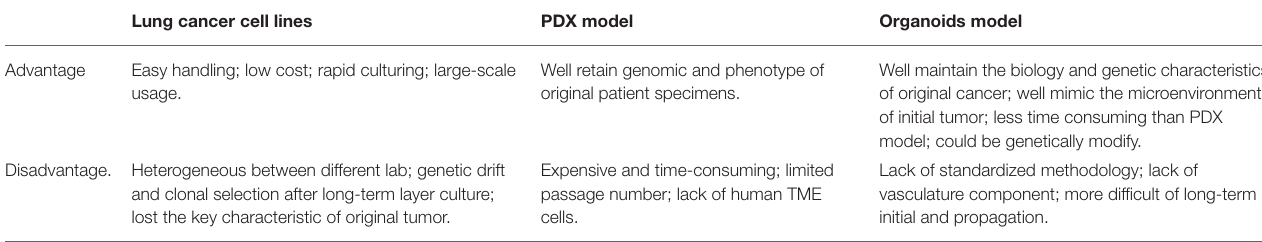
TABLE 1 | Comparison between different types of lung cancer study models. Lung cancer cell